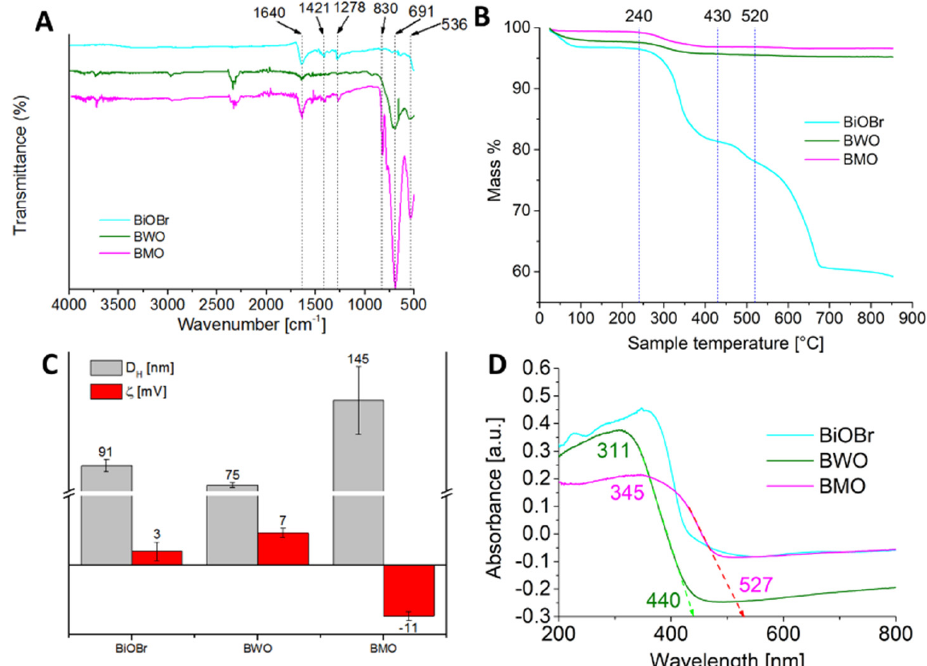
Figure 3. Samples characterization with ( A ) FTIR spectra of BiOBr, BWO, and BMO photocatalysts, ( B ) TGA of BiOBr, BWO, and BMO, ( C ) DLS and ELS of BiOBr, BWO, and BMO ( D ) DRS of BiOBr, BWO, and BMO. Arrows indicate band edge wavelenghts.